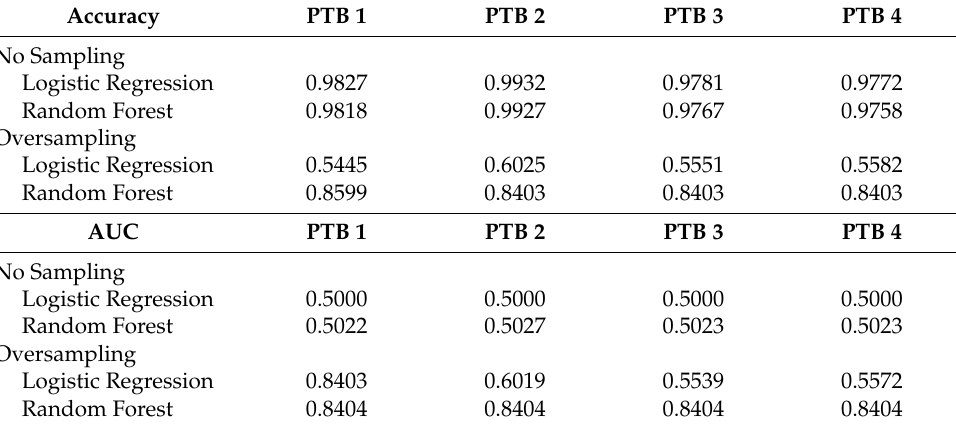
Table 1. Model performance.